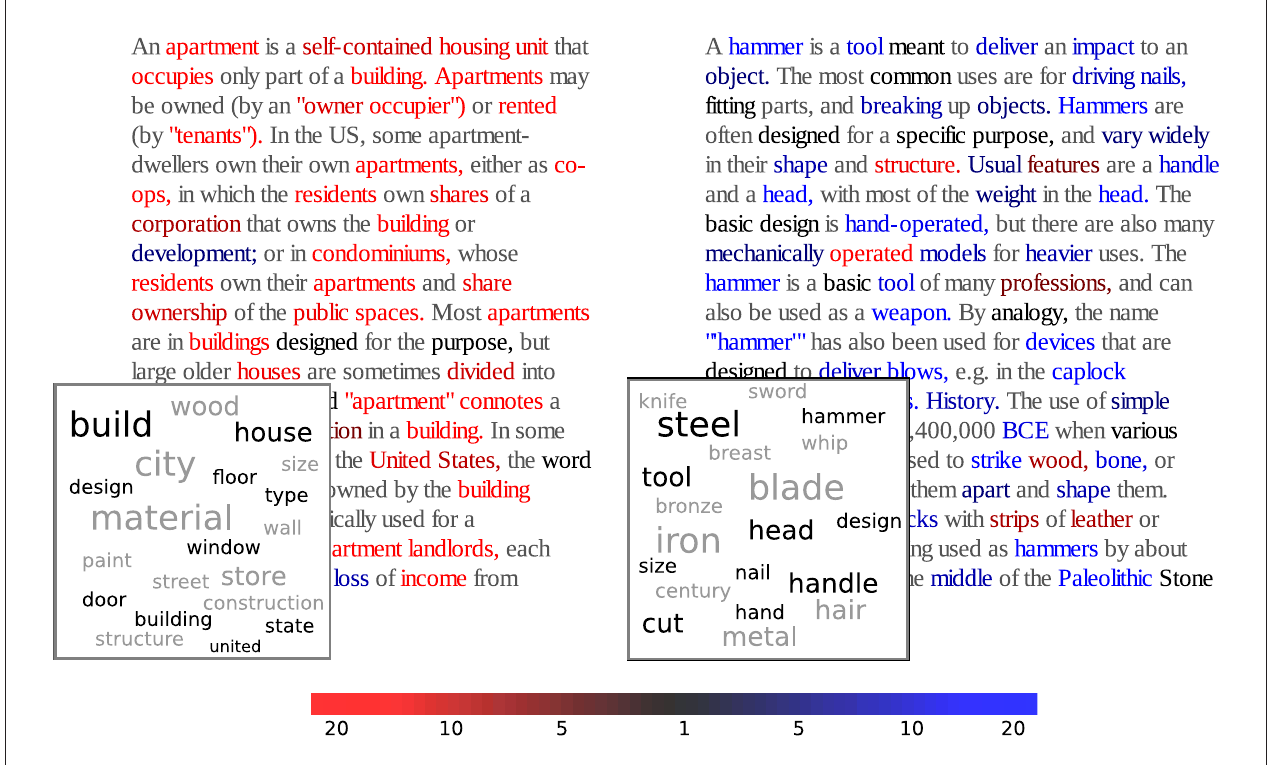
probabilities assigned to it by the brain-derived distributions for concepts FIguRe 3 | The inset under each article shows the top words from the “apartment” and “hammer” (red means higher probability under corresponding brain-derived distribution [10 which are present in the “apartment,” blue under “hammer,” gray means the word is not considered article (black) and 10 which are not (gray)]. Each word of the two articles is by the text colored to reflect the ratio p (word)/ p (word) between the apartment hammer